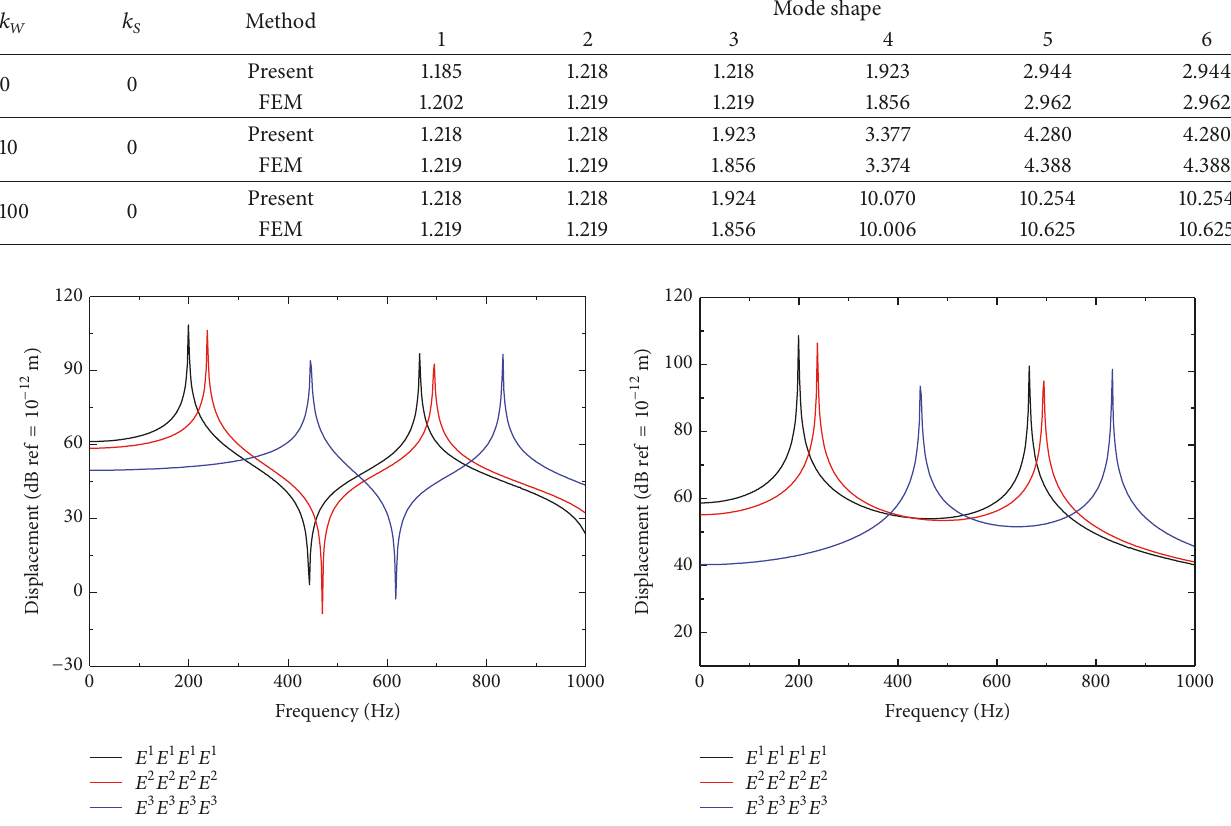
Table 5: Frequency parameter Ω for angle-ply (0/90 ∘ ) square plate with 8-point elastic supported boundary constraints and different foundation parameters (Material II) .